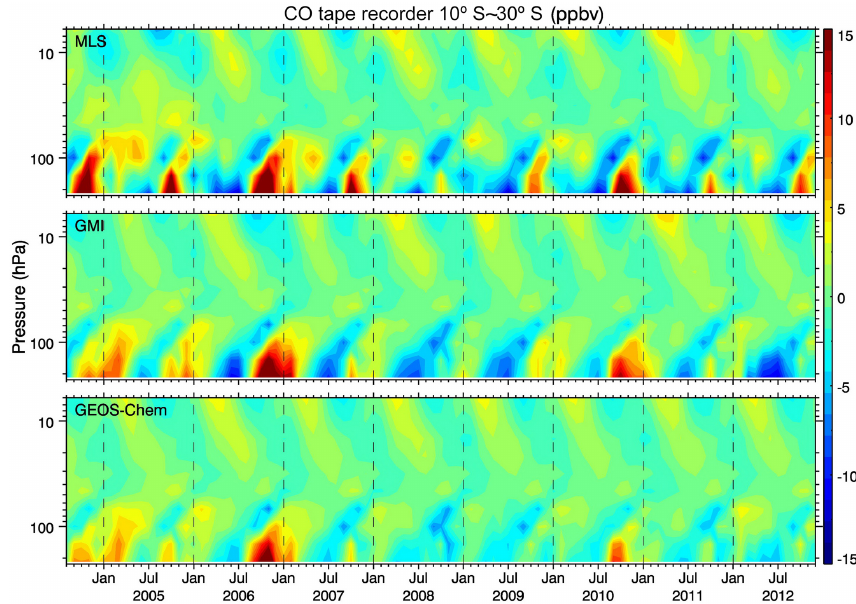
Figure 11. As in Fig. 9, but over the southern subtropics (10 ◦ –30 ◦ S).